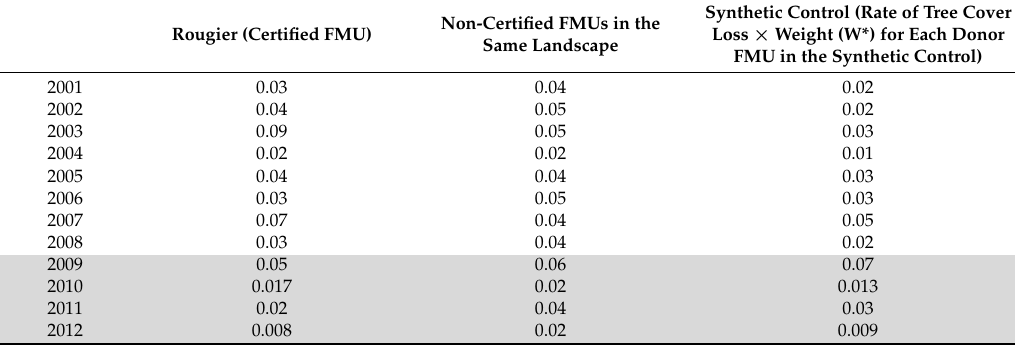
Table 2. Percent of tree cover lost annually in FMUs in Gabon. Shaded rows correspond to years after FSC certification of Rougier.